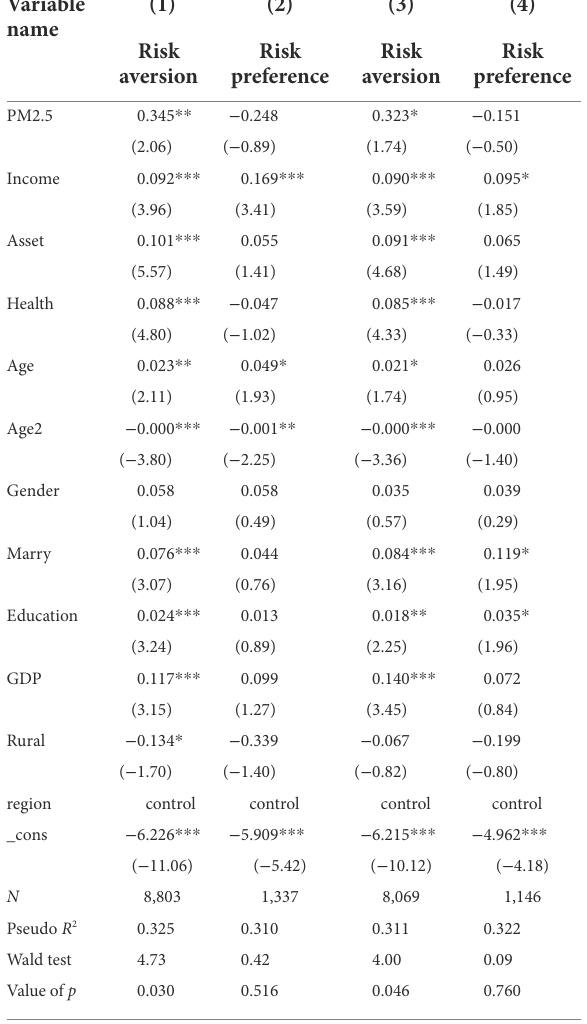
TABLE 8 The impact of haze pollution on demand for commercial health insurance: an analysis based on individual risk preference. Variable